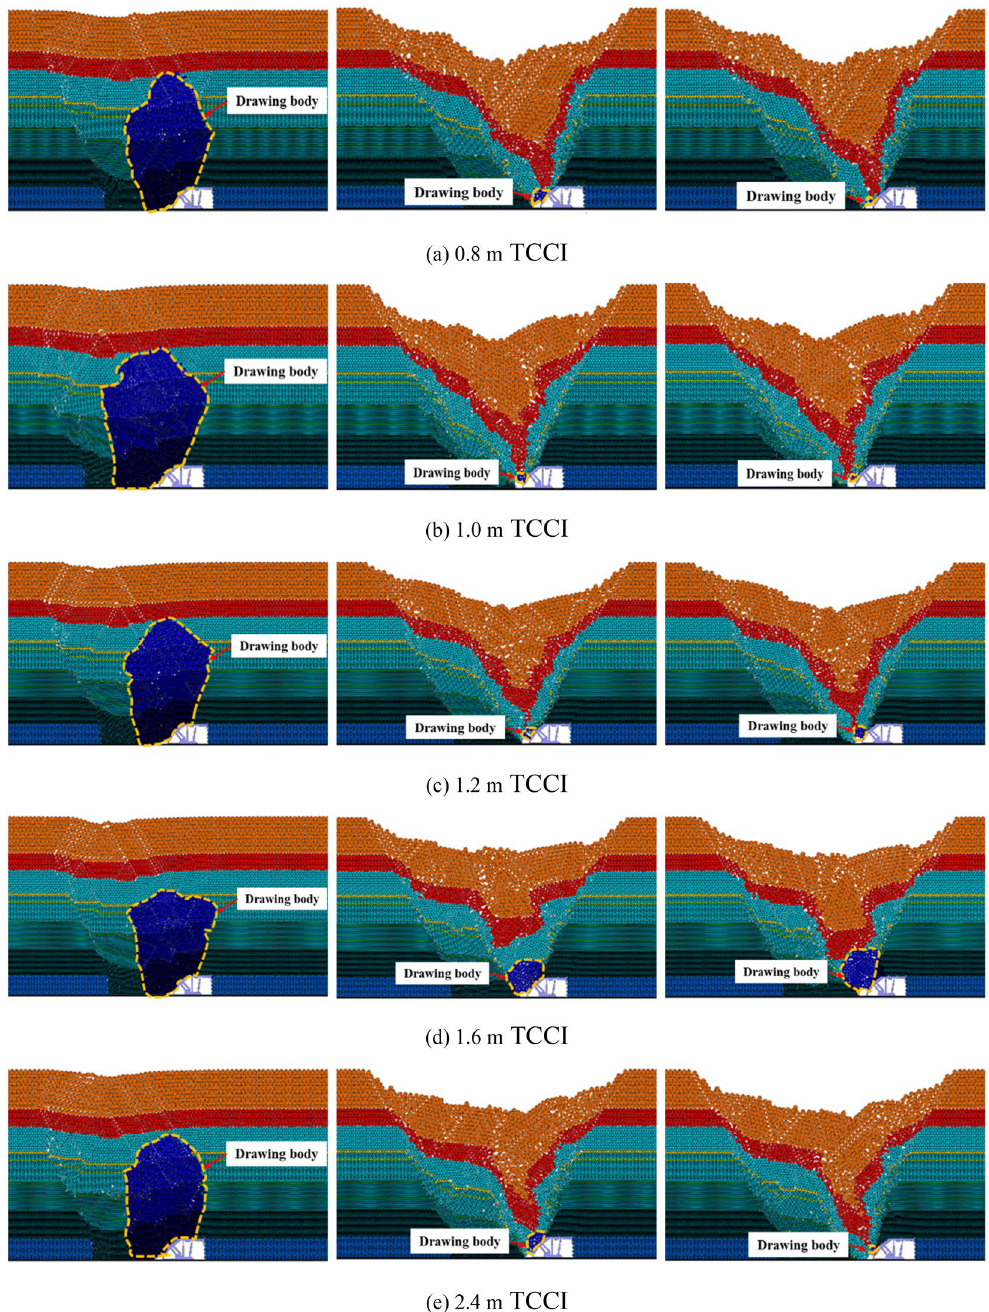
Figure 7. Inversion results of the first three top coal release body in different coal-drawing interval under 20.0 m top coal